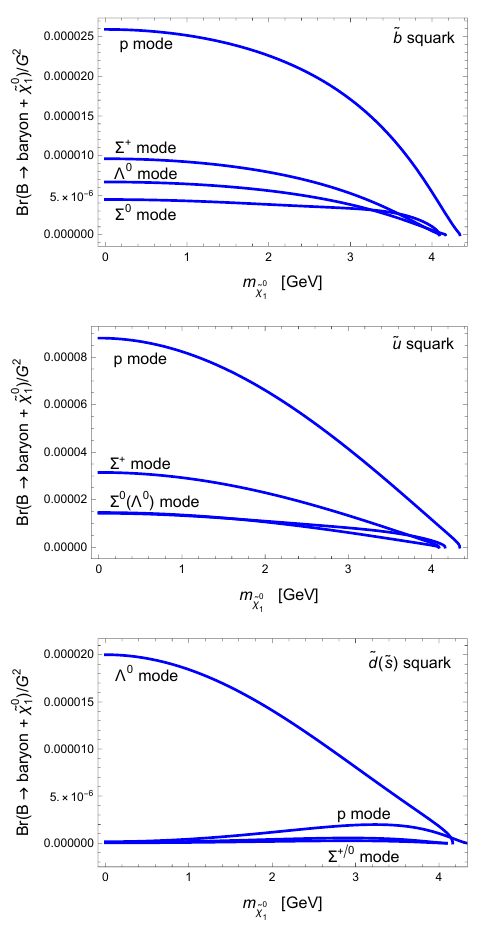
Figure 3 . Individual squark contributions to the branching fractions shown in figure